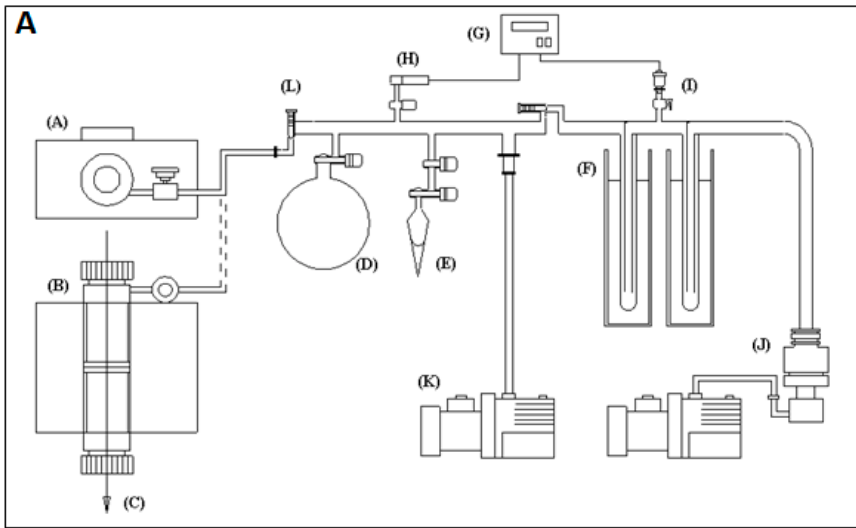
Figure 9. ( A ) Schematic diagram of the vacuum system and infrared (IR) cell used; (A) side view of IR cell, (B) top view, (C) IR beam, (D) gas bulb, (E) liquid bulb, (F) cold trap, (G) pressure gauge, (H) pirani probe head, (I) penning probe head, (J) diffusion pump, (K) roughing pump, and (L) Teflon valves. ( B ) A semi cross-sectional view of the in situ infrared cell. (1) Stainless steel body, (2) thermocouple, (3) cartridge heaters, (4) catalyst sample holder, (5) spacer, (6) CaF 2 windows, (7) Viton O-ring, (8) Teflon spacer, (9) screw cap filling, (10) connection to vacuum system, (11) cooling inlet, (12) cooling outlet. 4. Conclusions The adsorption of CO is studied by IR spectroscopy over nanoparticles of CeO 2 (in the range 5– 10 nm in size) at 90 K and resulted into the formation to two bands at 2183–2186 and 2161–2163 cm − 1 , with the former saturating first. The computed desorption energy, assuming a first-order desorption kinetic was found to be 0.35 eV for the 2186 cm − 1 and 0.30 for the 2163 cm − 1 IR peak (+/ − 0.05 eV). CO adsorption at 90 K on Rh/CeO 2 resulted (in addition to the bands on CeO 2 ) in the appearance of a broad band in the 2110–2130 cm − 1 region, that contained two components at 2116 and 2126 cm − 1 attributed to the adsorption on Rh cations of Rh clusters. This species was more stable than those on CeO 2 (it polluted the surface first and had a higher desorption energy, equal to 0.55 eV (+/ − 0.05 eV)). Heating the CO-covered Rh/CeO 2 surface accelerated the disappearance of CO species from CeO 2 at 150 K, and only species related to CO adsorption on Rh centers were found. The disappearance of CO on Rh particles coincided with the formation of carbonate species which dominated the surface at 300 K. Author Contributions: Conceptualization (H.I.), Methodology (H.I.), Investigation (H.I. and J.L.), Writing- Original Draft (H.I. and